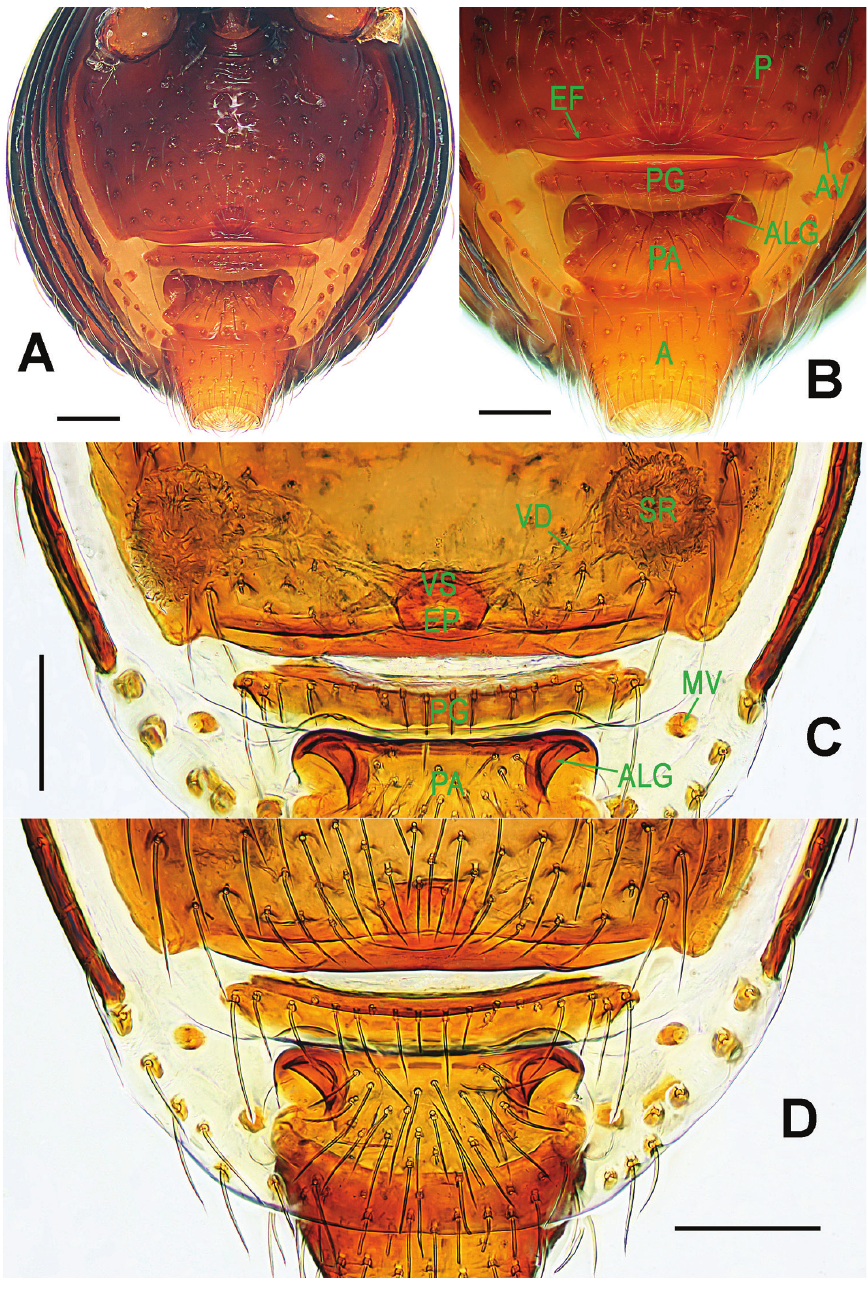
Figure 15. Brignoliella michaeli Lehtinen, 1981, female from Singapore. A opisthosoma B genital area (untreated) C cleared vulva (lactic acid-treated) D ditto . A–B, D ventral C dorsal. Abbreviations: A = anal plate; ALG = anterolateral groove of preanal plate; AV = anterior ventrolateral plate; EF = epigynal fold; EP = epigynal pit; MV = median ventrolateral plate; P = pulmonary plate; PA = preanal plate; PG = postgenital plate; SR = seminal receptaculum; VD = vulval duct; VS = vulval stem. Scale bars: 0.10